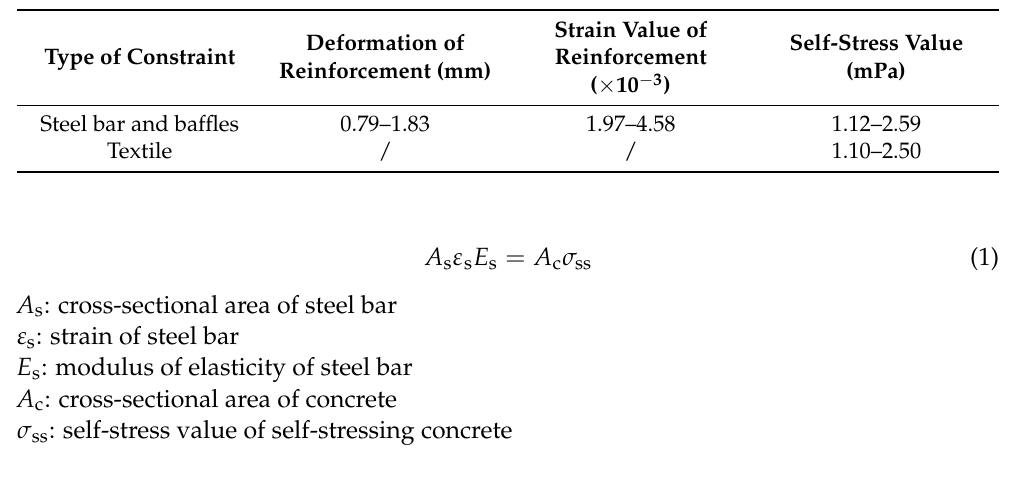
Table 4. Data of the self-stress value test.